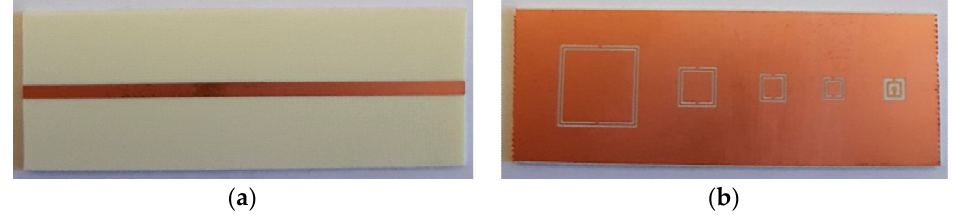
Figure 3. Fabricated sensor array ( a ) front surface and ( b ) back surface.